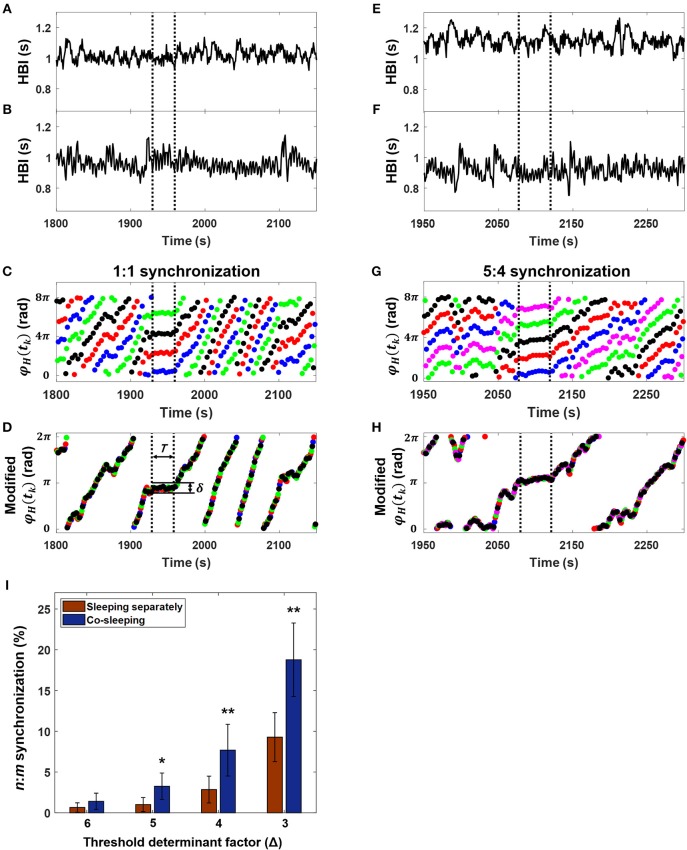
Interindividual heart rhythm phase synchronization (IHPS). (A) Heartbeat intervals (HBI) of a subject over 350 s. (B) The HBI of a co-sleeper during the same time interval as in (A). (C) The corresponding synchrogram φH (tk) with a 1:1 ratio; each colored dot indicates n subgrouped heartbeats for the subject over m heartbeat cycles for the co-sleeper. (D) The synchrogram φH (tk) divided by m is then subtracted by each of 2 πρ / n where ρ = 1, 2, ···, n, and finally wrapped into 0, 2π interval. IHPS (between the vertical dashed lines) is determined for the segment in which variation between the points is lower than the threshold level (δ = 2 π /nΔ) maintaining a sufficient time duration (T). (E) The HBI of another over 350 s. (F) The HBI of a co-sleeping individual within the same time interval as that in (E). (G) The corresponding synchrogram. (H) The synchrogram φH (tk) is expressed using the procedure explained in (D) and the IHPS for a 5:4 ratio (between vertical dashed lines). Note that the segments in (A,B) and in (E,F) were chosen as examples from the entire recordings of co-sleeping individuals to explain the presence of IHPS with different ratios. (I) IHPS in different sleep conditions according to the threshold determinant factor (Δ). The degree of IHPS obtained by averaging the percentage of synchronization for each pair of individuals in different sleep conditions. The n:m ratios are set m to 1 ≤ m ≤ 10 and n to m ≤ n ≤ m + 2. A significantly higher IHPS is observed in co-sleeping individuals (blue bars) than in individuals sleeping separately (red bars), especially at Δ values of 5, 4, and 3. The error bars indicate the standard error. Comparison of the IHPS between co-sleeping individuals and individuals sleeping separately revealed *p < 0.03 at a Δ of 5 and **p < 0.02 at Δ of 4 and 3 (Wilcoxon signed-rank test), indicating that IHPS is significant in co-sleeping individuals when compared with individuals sleeping separately.